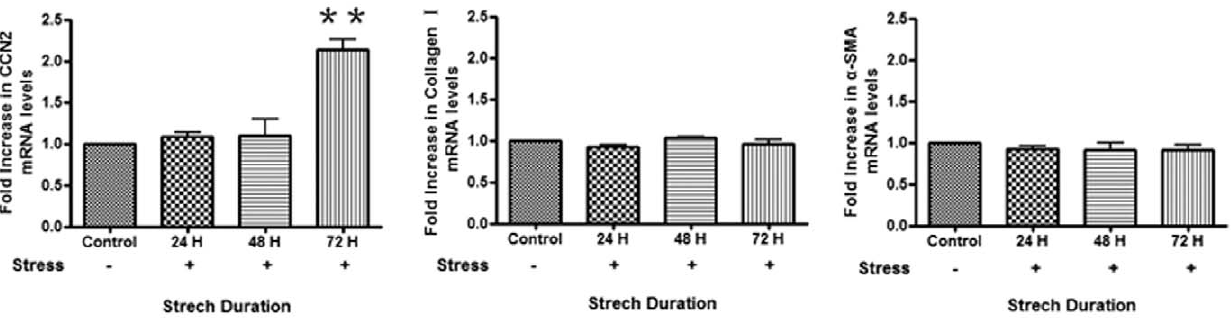
Figure 1. Mechanical strain induces CCN2/CTGF mRNA expression in human gingival fibroblasts (HGF). As described in Methods, equal numbers of HGF were seeded into plates containing collagen type I-coated membranes and subjected to the presence or absence of mechanical strain for up to 72 hours. Total RNA was harvested, and subjected to real-time PCR analysis with primers detecting CCN2, collagen type I (Col1a2) or a -SMA. Expression values are adjusted to those of controls (18S) run in parallel. Experiments were performed on cells derived from three different individuals, with quadruplicate replicate samples. Relative expression at time zero (control) was taken to represent 1. Fold increase in relation to time zero (control) is shown. Data shown are the average value from three independent individuals (3 replicates per experiment ) 6 SE. **=p , 0.01. Note that a -SMA and Col1a2 mRNAs were not significantly induced by strain. Similar results were obtained if cells were plated on laminin-coated membranes (not